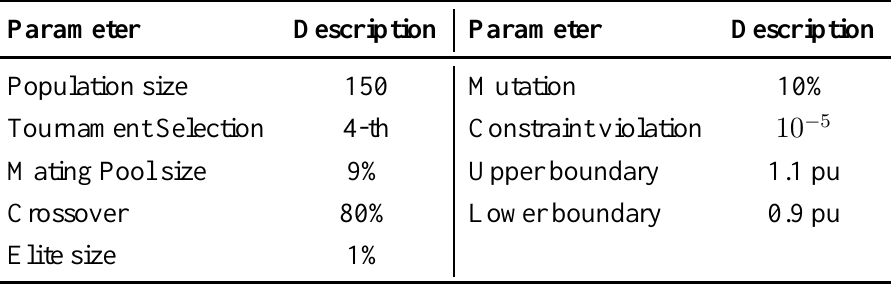
Table 3. Genetic Algorithm